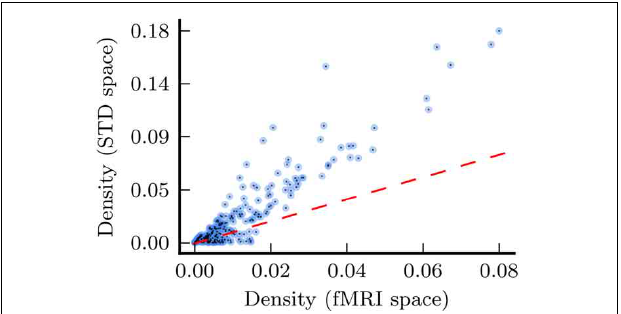
FIGURE 8 | Density for every network in the analysis, with density for fMRI space networks plotted against density for the corresponding standard space networks. The dashed red line shows the relationship x = y for the purposes of